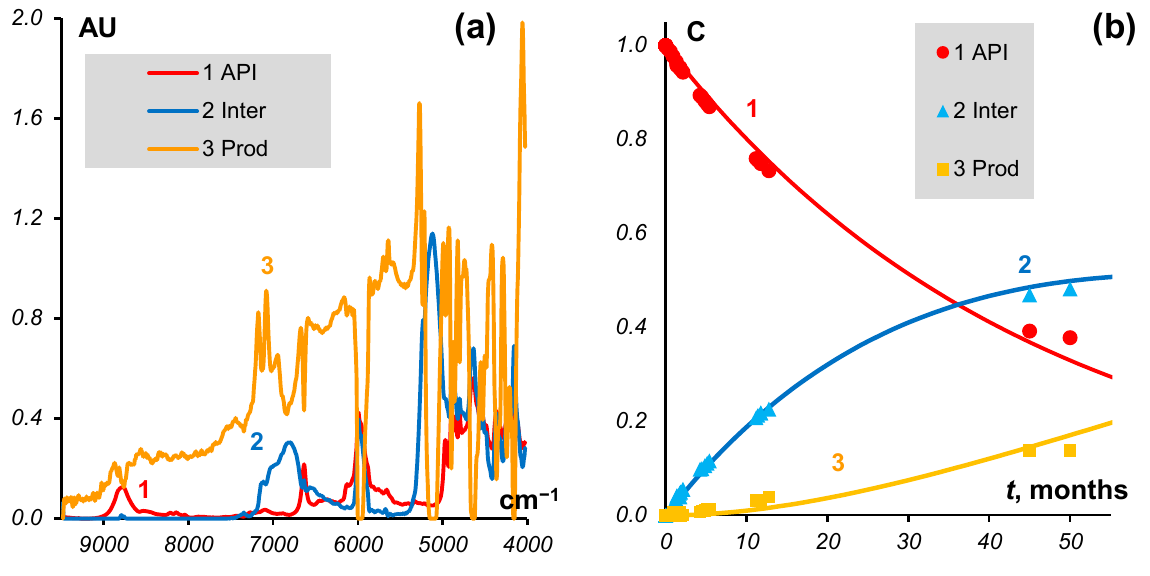
Figure 2. MCR model for substances. ( a ) Spectra of API , Inter , and Prod ( b ) Concentrations (markers) and kinetics (curves).